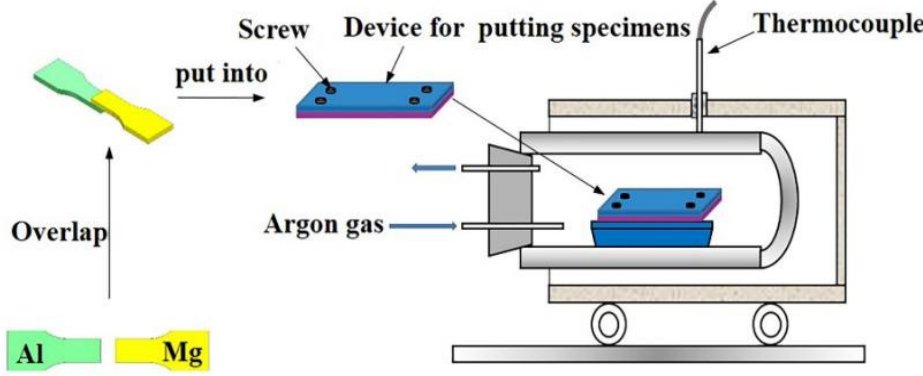
Figure 1. Flow chart of the vacuum diffusion welding process.